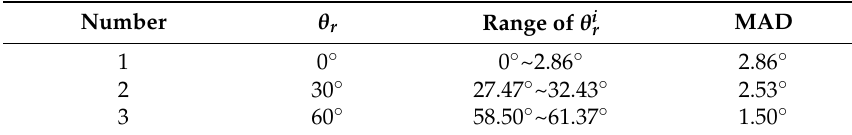
Table 1. The relation between θ r and the range of θ i r .